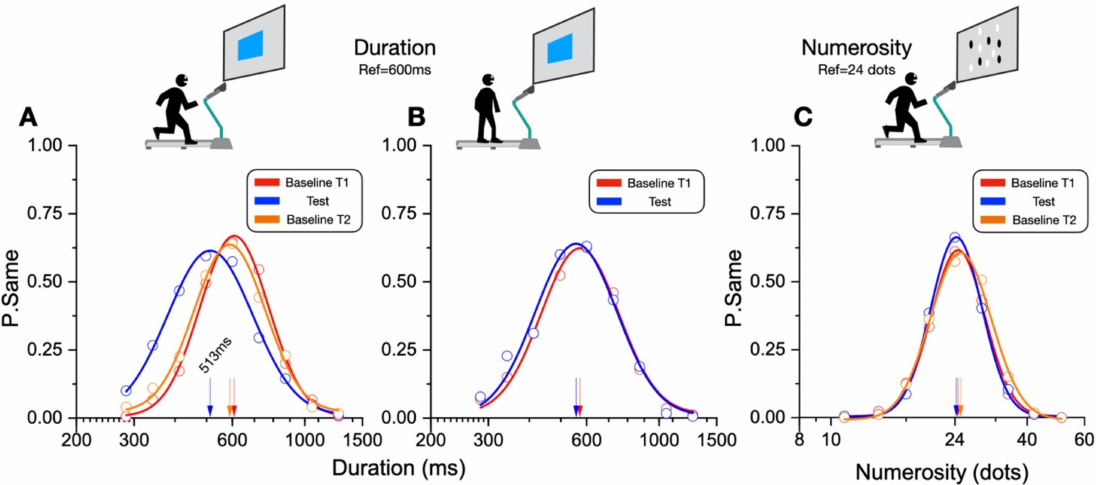
Figure 3. Results on aggregate data for the duration ( A , B ) and numerosity ( C ) tasks. Test stimuli magnitudes were plotted against the proportion of “same” responses and fitted with Gaussian functions. The peaks of the fits (arrows) correspond to the PSE (600 ms or 24 dots). A leftward shift (relatively lower peaks values) corresponds to an overestimation of the duration or numerosity of the test